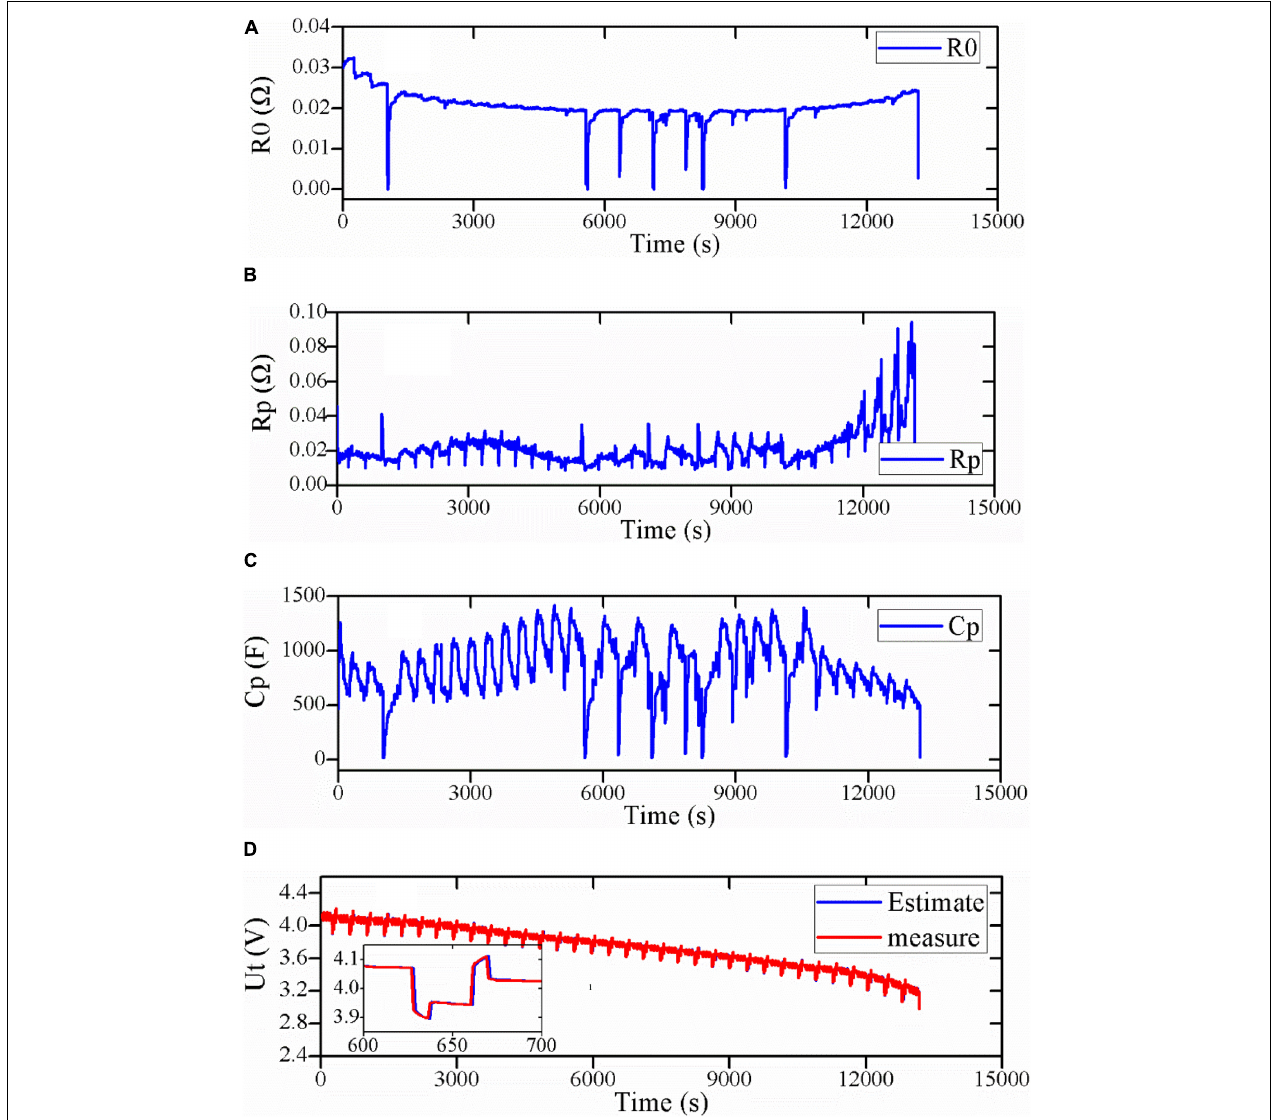
FIGURE 5 | Parameter identification results. (A) R0 ; (B) Rp ; (C) Cp ; (D) comparison of the estimated Ut with the measured